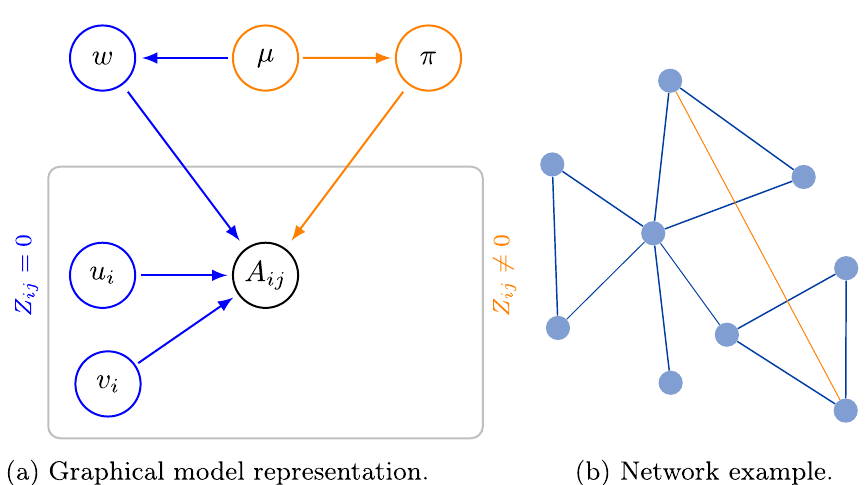
Fig. 1 Model visualization. a Graphical model: the entry of the adjacency matrix A ij is determined by the community-related latent variables u , v , w (blue), and by the anomaly parameters π (orange), depending on the values taken by the hyper-prior µ . b Example of possible realization of the model: blue edges display interactions mainly based on the community, the orange edge exhibits an anomalous